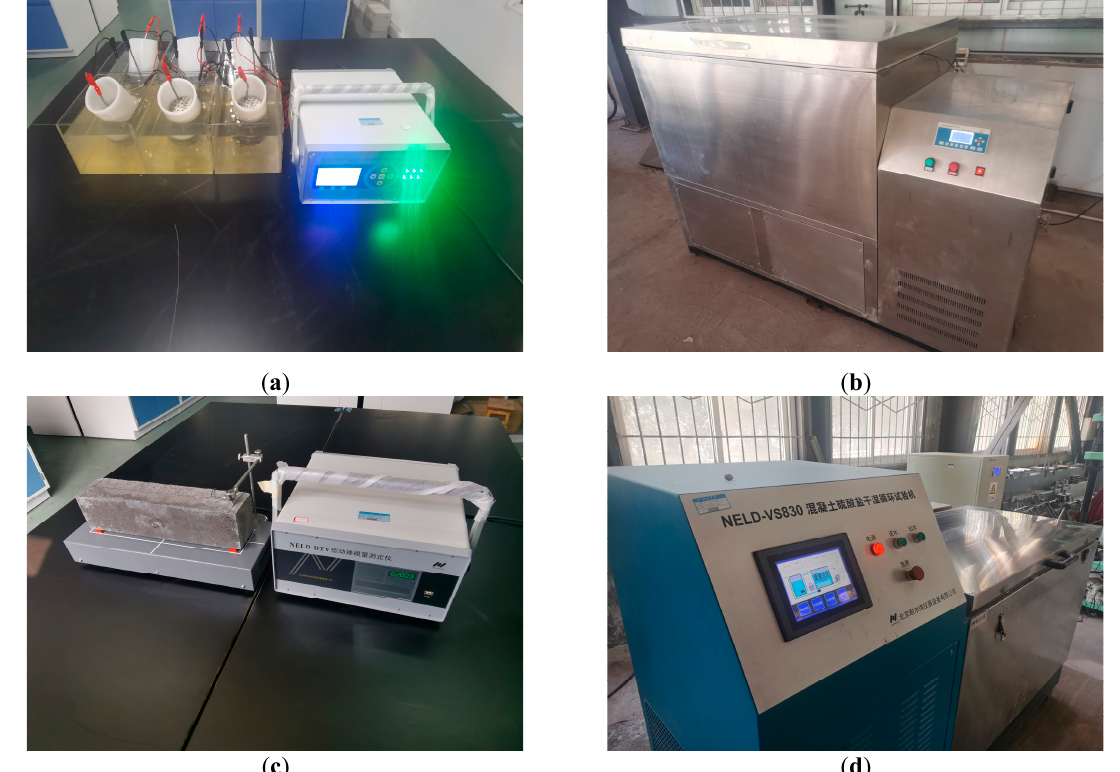
Figure 6. Test device for durability: ( a ) test device for rapid chloride ions migration (RCM) method, ( b ) freezing–thawing testing machine, ( c ) test device for dynamic modulus of elasticity, and ( d ) sulfate attack testing